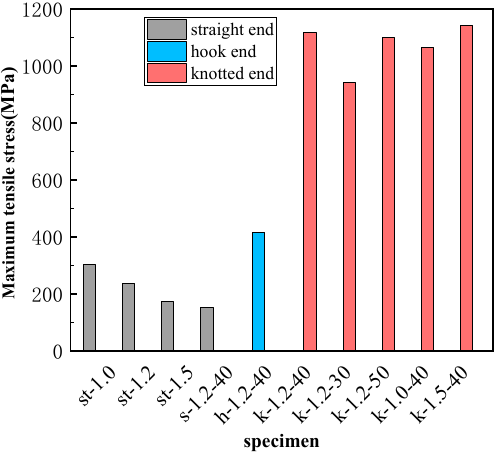
Figure 10. Comparison of the maximum pullout stress of each specimen.